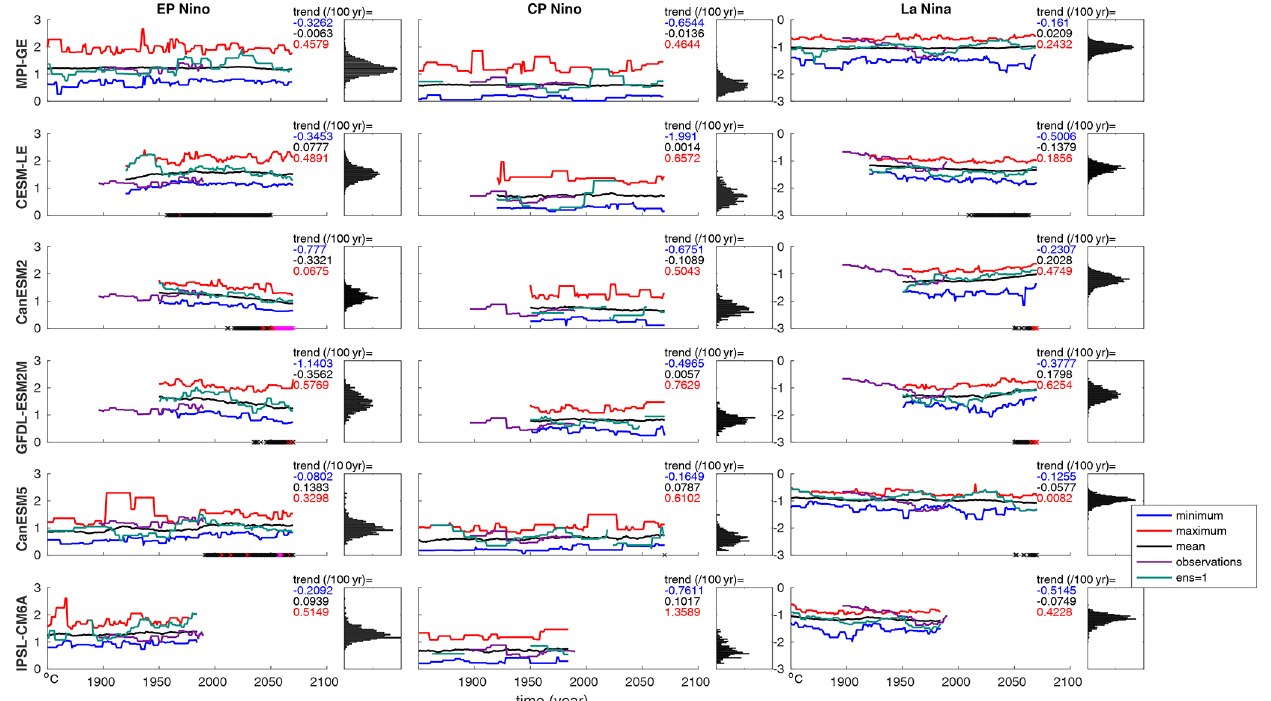
Figure 4. ENSO amplitude in each SMILE for EP and CP El Niño events and for La Niña events (left, middle ,and right columns respec- tively). Black line shows the ensemble mean for each year, red line shows the ensemble maximum, blue line shows the ensemble minimum, purple line represents HadISST observations, and green line is the first ensemble member. Amplitude is calculated as the November, De- cember, January mean for the region 160 ◦ E to 80 ◦ W between 5 ◦ N and 5 ◦ S after the ensemble mean has been removed for each event in a single ensemble member, taken as a running calculation along the time series for 30-year periods. PDFs show the distribution of ensemble members for the entire time series. Black dots on the x axis demonstrate when the signal (current ensemble mean minus the ensemble mean at the beginning of the time series) is greater than the noise (standard deviation taken across the ensemble). Red dots show when the signal is 1.645 times the noise, while magenta dots show the same when the signal is greater than 2 times the noise. These thresholds correspond to the likely , very likely , and extremely likely ranges. Maximum (red), mean (black), and minimum (blue) trends across the individual ensemble members are shown in text at the top right of each panel. We note that the trends are calculated over the entirety of the simulation length for each SMILE. This means that due to the different time periods covered, trends are not directly comparable between different SMILEs.